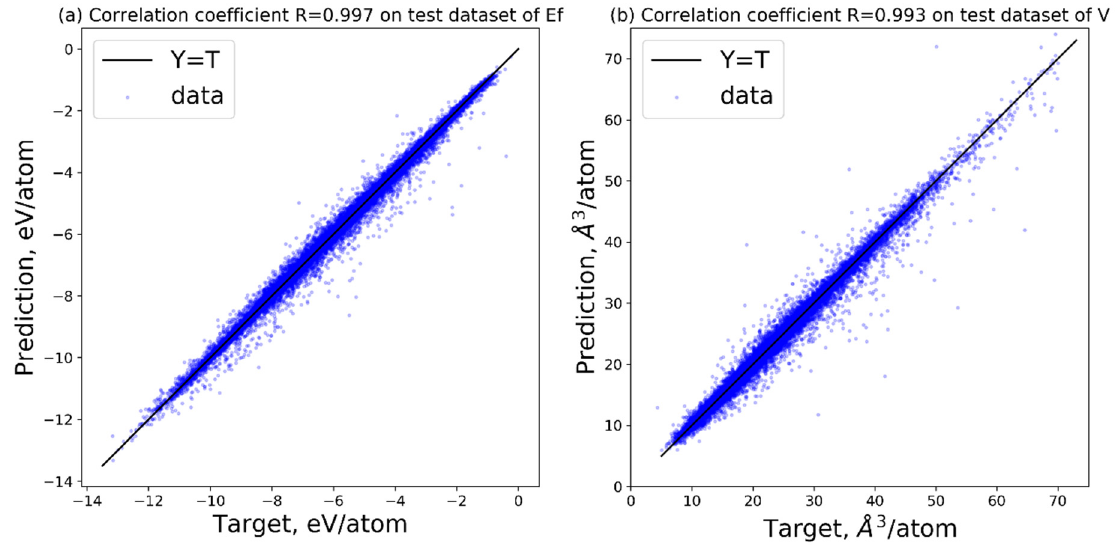
Figure 4. Ground truth on the x-axis, T, and predicted value on the y-axis; ( a ) energy entropy; ( b ) volume.